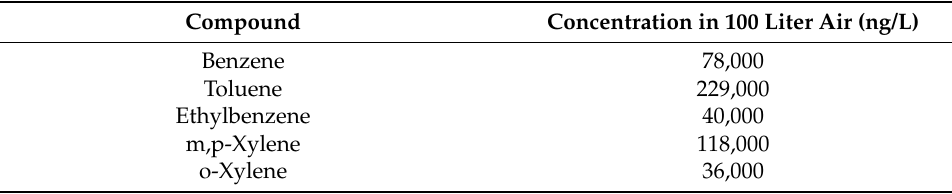
Table A2. Average concentration of the BTEX compounds in the